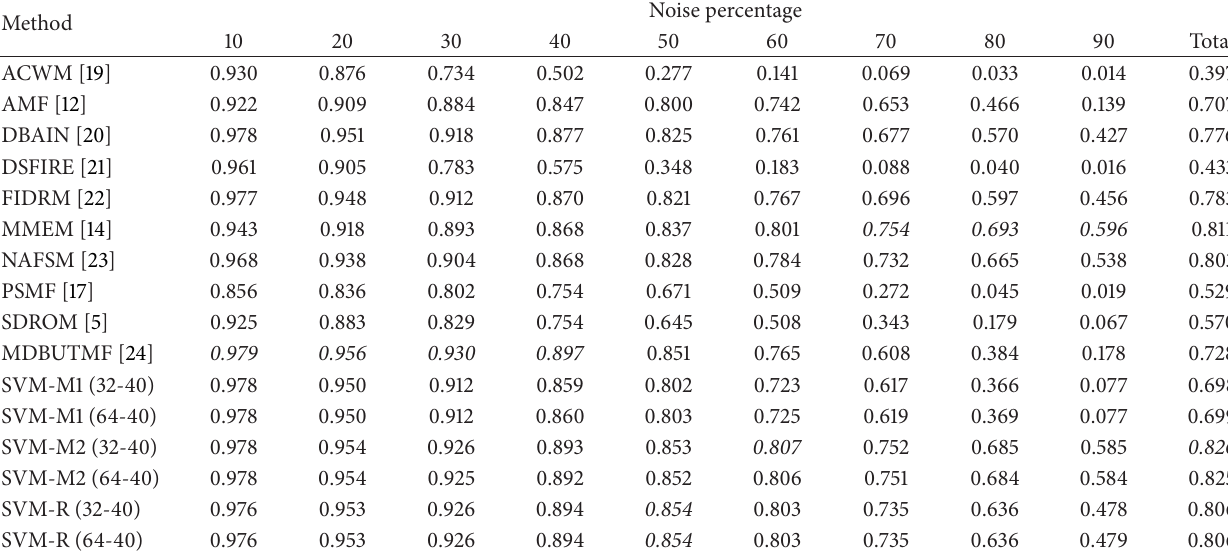
Table 4: Table results in mean MSSIM for different impulse noise reduction methods. The mean is obtained for different noise ratios in 10 test images. Total column reflects the total mean for all ratios and